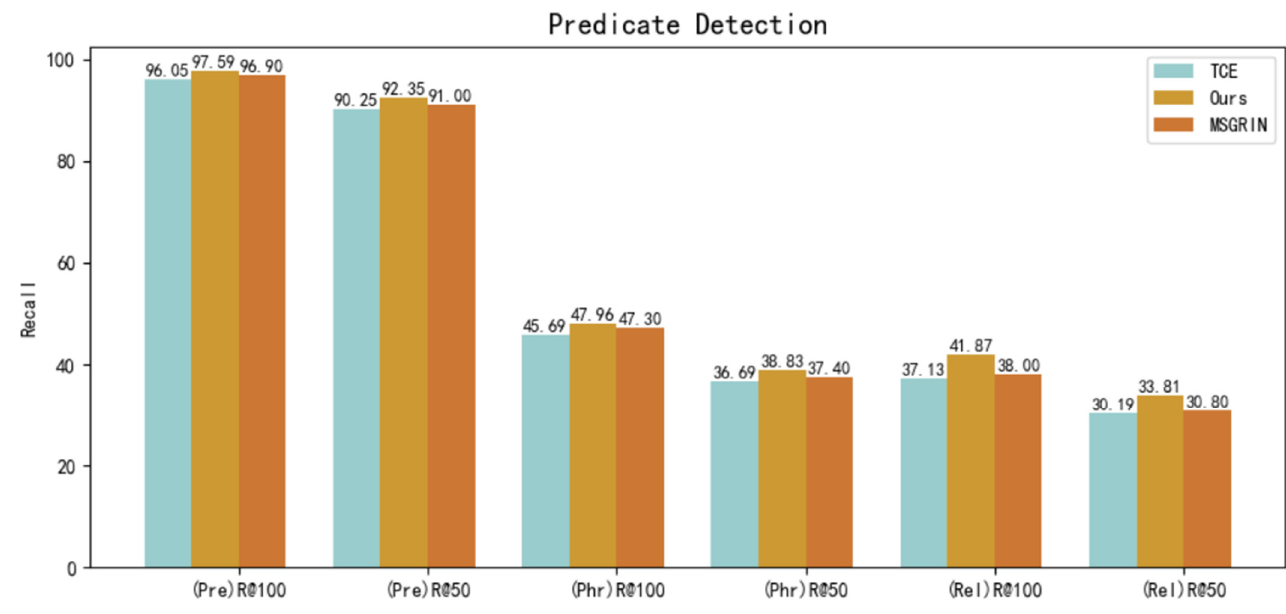
Figure 3. While k is set 70, our method surpasses TCE and MSGRIN in R@n, reaching state-of-the-art results in predicate detection.